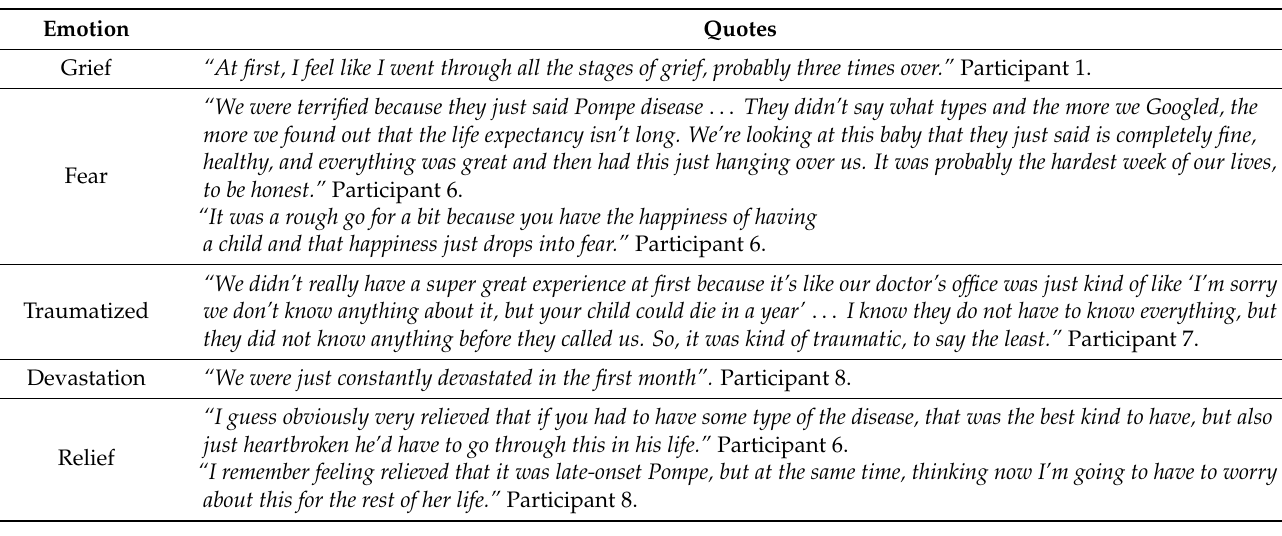
Table 4. Emotions related to the initial NBS result, waiting period, and diagnosis of